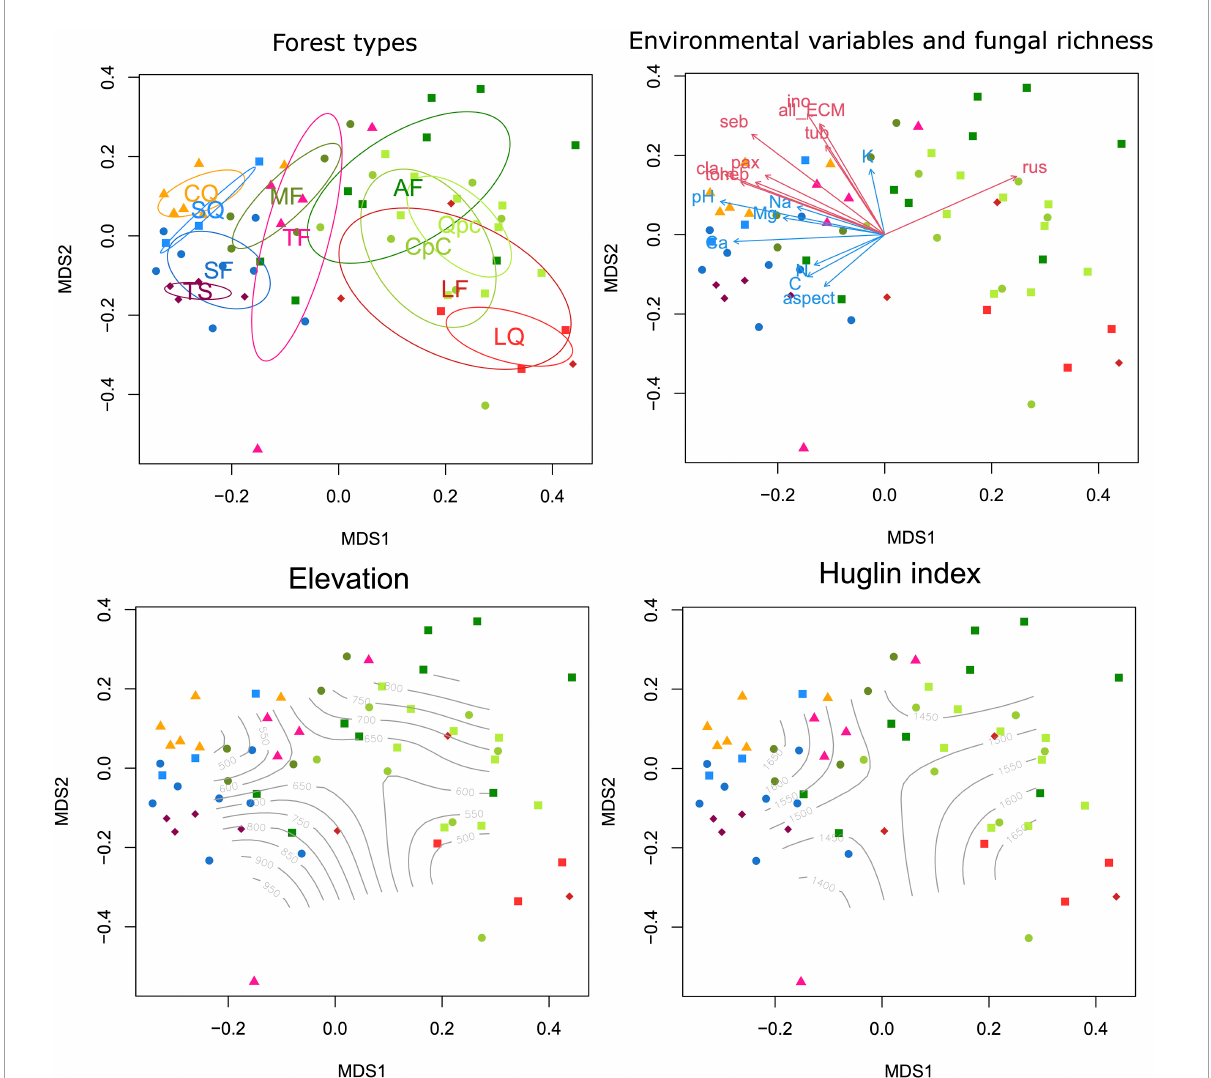
FIGURE4 Non-metric multidimensional scaling (NMDS) ordination plot (final stress: 0.15734) of the total ectomycorrhizal (ECM) fungal community in the sampled forest types based on Hellinger-transformed data. Ellipses indicating standard deviation of compositional differences of forest types, vectors of environmental variables and richness values of ECM fungal lineages showing significant correlations with ordination axes, and isolines of elevation and Huglin index are displayed in four identical ordination